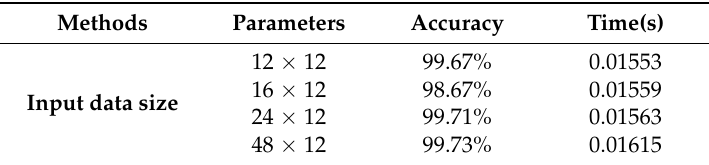
Table 4. Analysis of results with different data Table 7. Analysis of results with different data sizes.